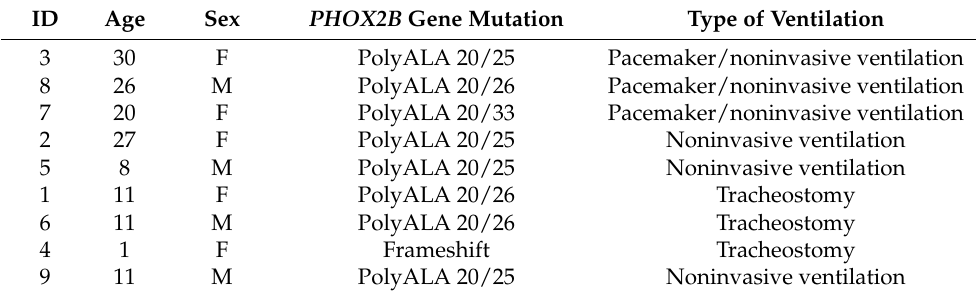
Table 1. Demographic and clinical characteristics of enrolled CCHS